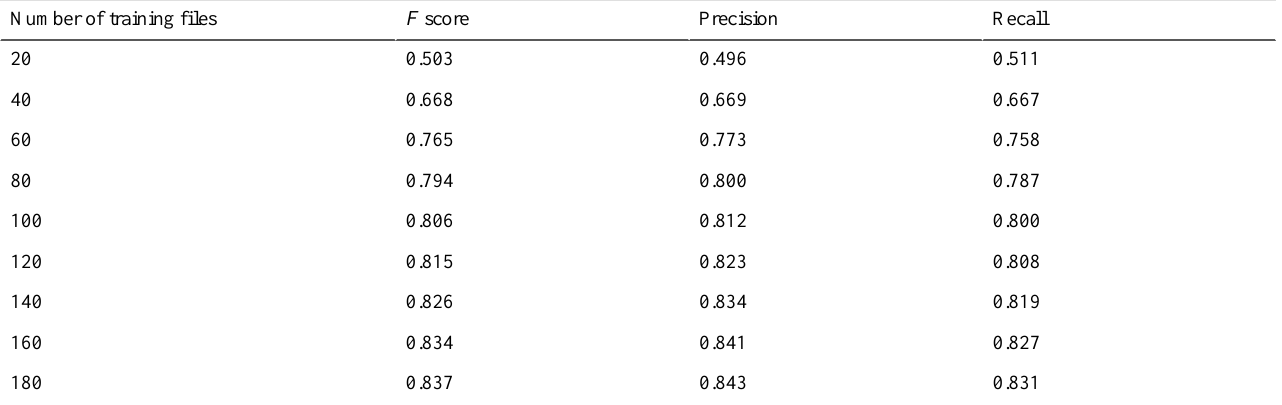
Table 7. Dependency of the accuracy on training data volume for the author detection